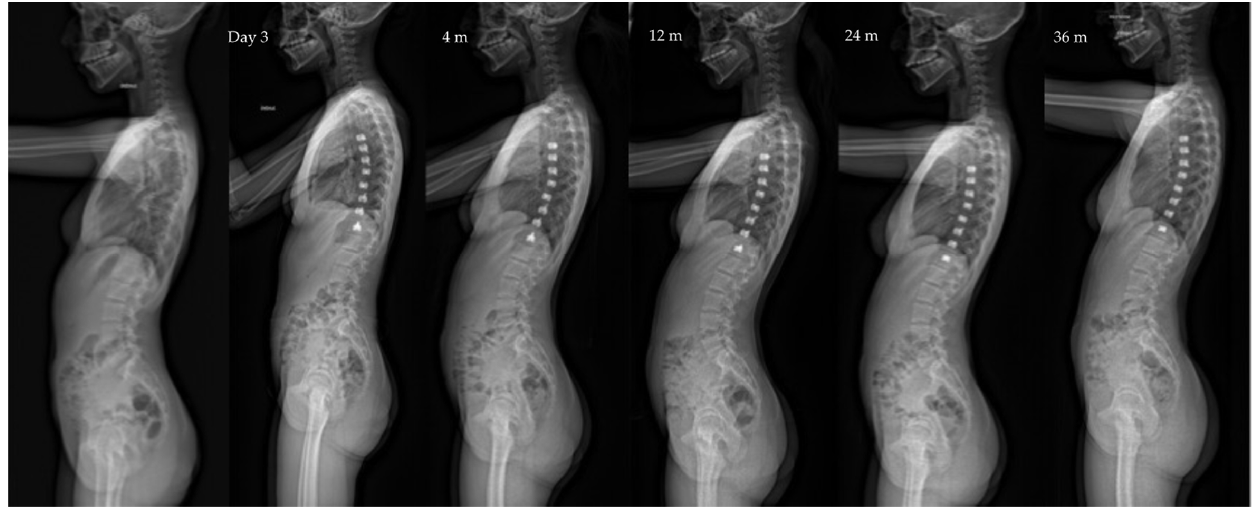
Figure 2. Same patient as Figure 1 Lateral view X-rays throughout follow-up, showing the slight kyphosis improvement and lordosis stability: kyphosis and lordosis are, respectively, 26/55 pre-op, 30/55 at 4 months po, and 35/58 at 36 months po.